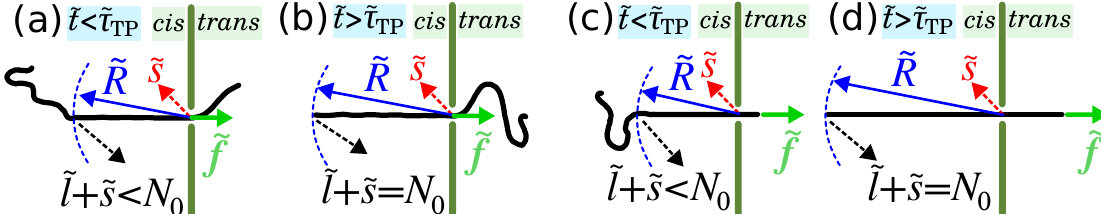
Figure 8. ( a ) Schematic of the pore-driven translocation process during tension propagation (TP) stage, i.e., ˜ t < ˜ τ TP , for the SS regime. The external driving force ˜ f acts only on the monomer(s) at the pore towards the trans side. N 0 is the contour length of polymer, and ˜ s is the number of segments that have already been translocated into the trans side. ˜ l + ˜ s is the number of beads influenced by the tension force which is less than N 0 during the TP stage. ˜ R denotes the location of the tension front. ( b ) Translocation process for the SS regime in the post propagation (PP) stage when the tension has reached the chain end and after that, i.e., ˜ l + ˜ s = N 0 . ( c ) The same as ( a ) but for the end-pulled polymer translocation process, where the external driving force acts only on the head monomer in the direction perpendicular to the membrane from cis to trans side. ( d ) The same as ( b ) but for the end-pulled case. The shape of the mobile subchain depends on the strength of the driving force. For the pore-driven case in the limit of weak ( N − ν